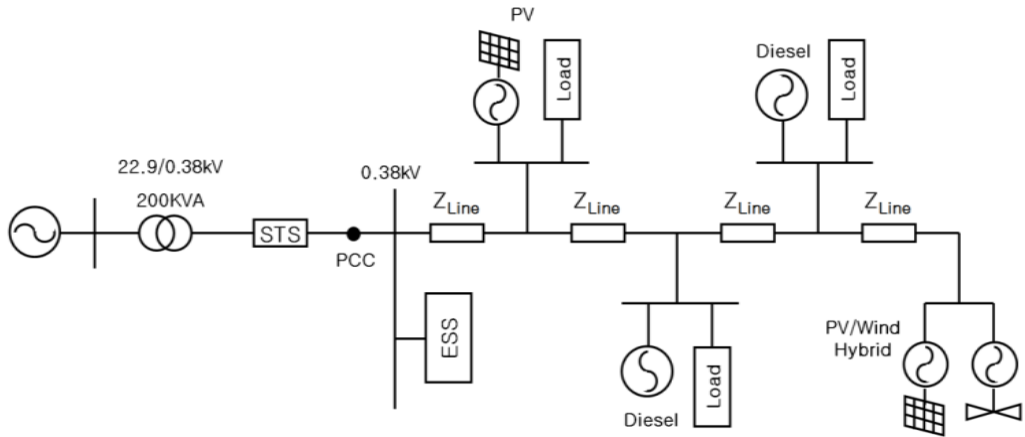
Figure 14. Configuration for a test microgrid